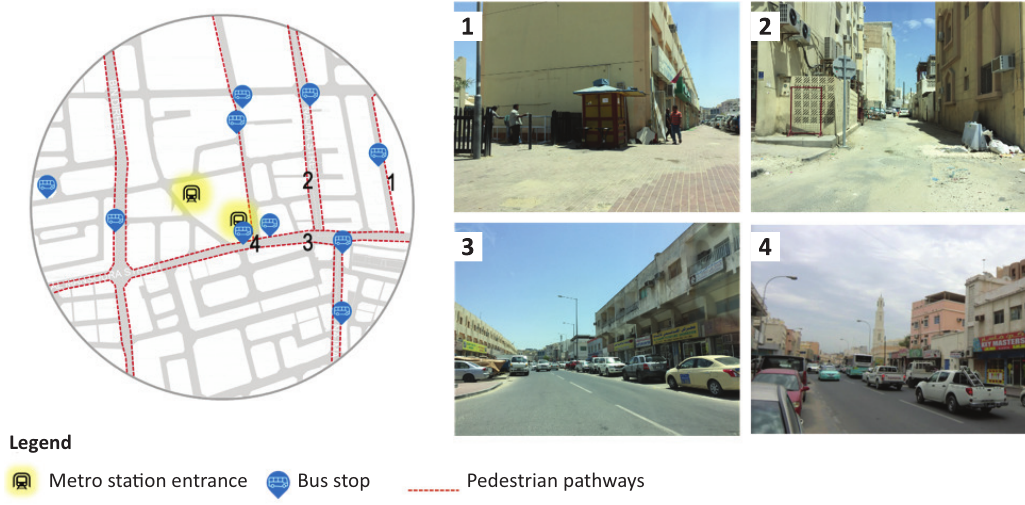
Figure 10. Available transportation modes within 400 m of the